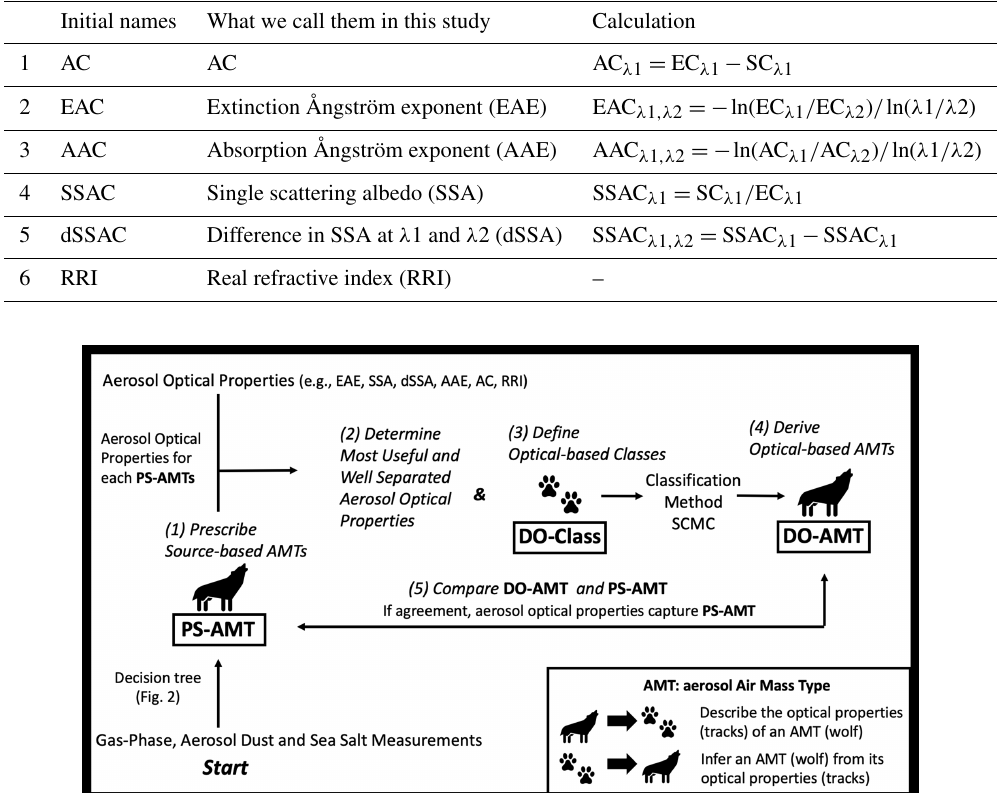
Figure 1. Overall method in this study. PS-AMTs: prescribed source-based air mass types (AMTs); DO-Classes: defined optical-based class definitions; DO-AMTs: derived optical-based AMTs; EAE: extinction Ångström exponent; SSA: single scattering albedo; dSSA: difference in SSA; AAE: absorption Ångström exponent; AC: absorption coefficient; RRI: real refractive index; SCMC: pre-specified clustering and Mahalanobis classification. The concept of the wolf and its tracks is based on the dragon and its tracks in Bohren and Huffman